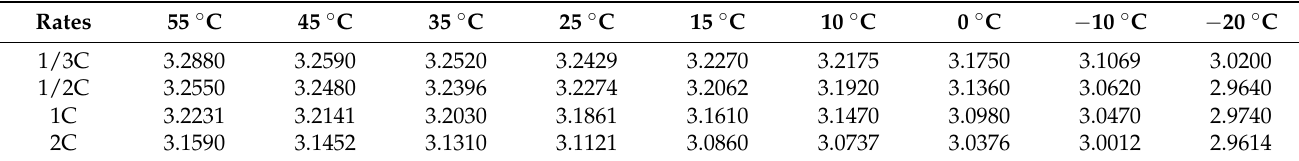
Table 2. The average output voltage of the battery under 36 discharging